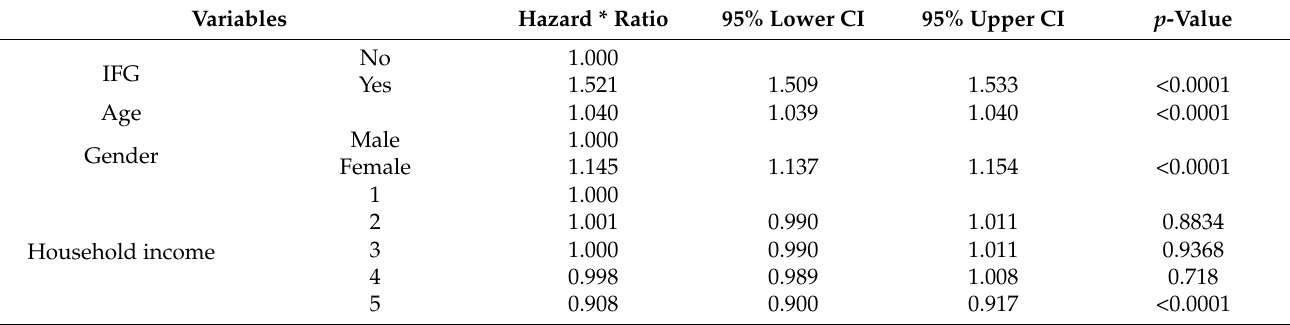
Table 5. Risk factors for the progression from non-diabetes to diabetes from age